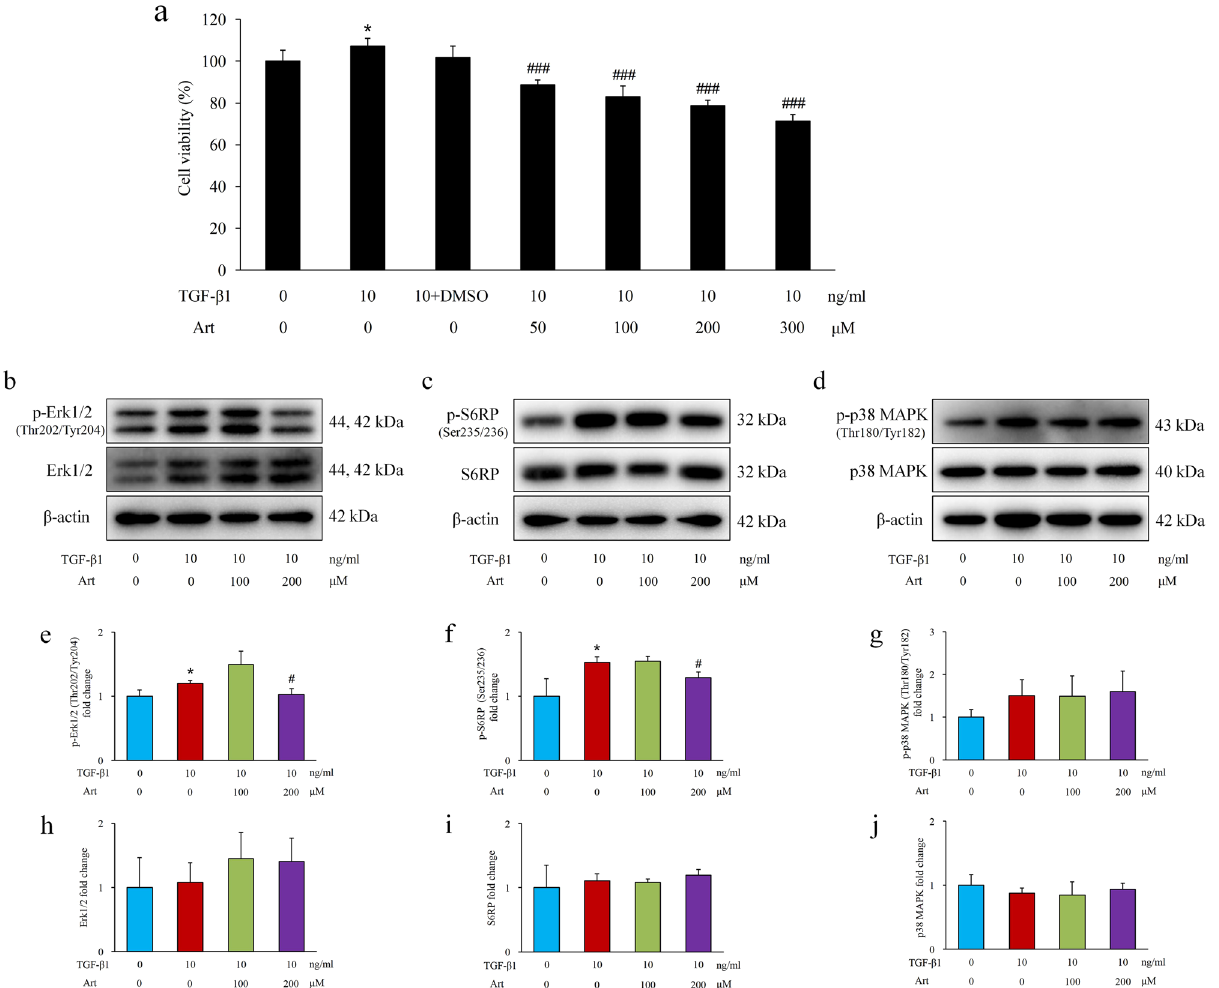
Figure 5. Effects of artemether on cell viability and proliferation-related signalling pathways in vitro. ( a ) Cell viability was analysed by MTT assay after treatment with TGF-β1 and different concentrations of artemether for 24 h. n = 6 per group. * P < 0.05 vs. TGF-β1:0 + Art: 0 group; ### P < 0.001 vs. TGF-β1:(10+DMSO) + Art: 0 group. ( b – d ) Representative western blot bands of p-Erk1/2 (Thr202/Tyr204), Erk1/2, p-S6RP (Ser235/236), S6RP, p-p38 MAPK (Thr180/Tyr182), and p38 MAPK after treatment with the indicated amount of artemether and TGF-β1. ( e – j ) Bar graphs presenting the fold change of these proteins after normalization to β-actin. n = 3 per group. * P < 0.05 versus TGF-β1:0 + Art: 0 group; # P < 0.05 versus TGF-β1:10 + Art: 0